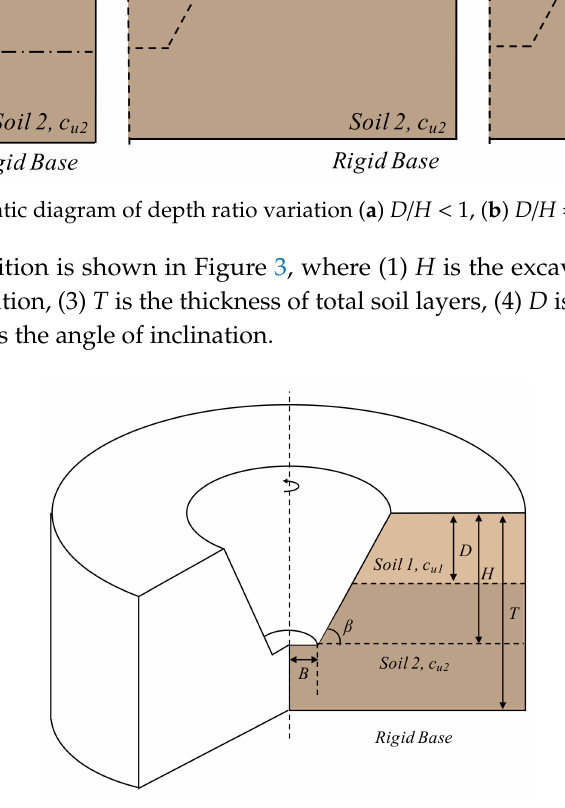
Figure 3. Problem notation of an unsupported conical